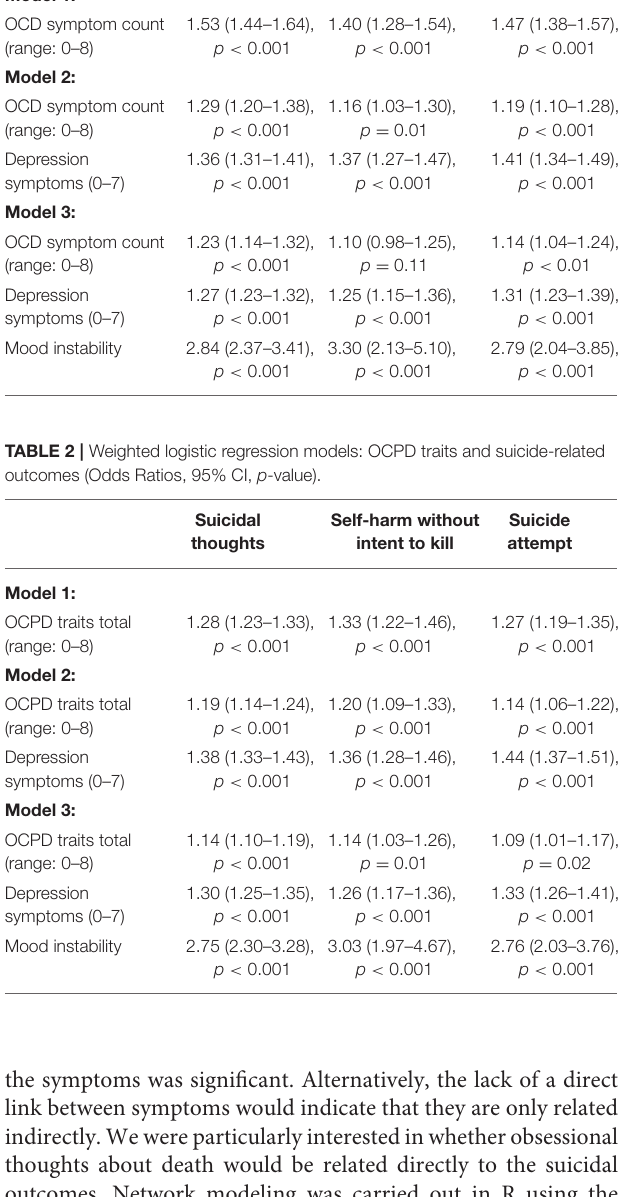
TABLE 1 | Weighted logistic regression models: OCD and suicide-related outcomes (Odds Ratios, 95% CI, p -value). Suicidal Self-harm without thoughts intent to kill